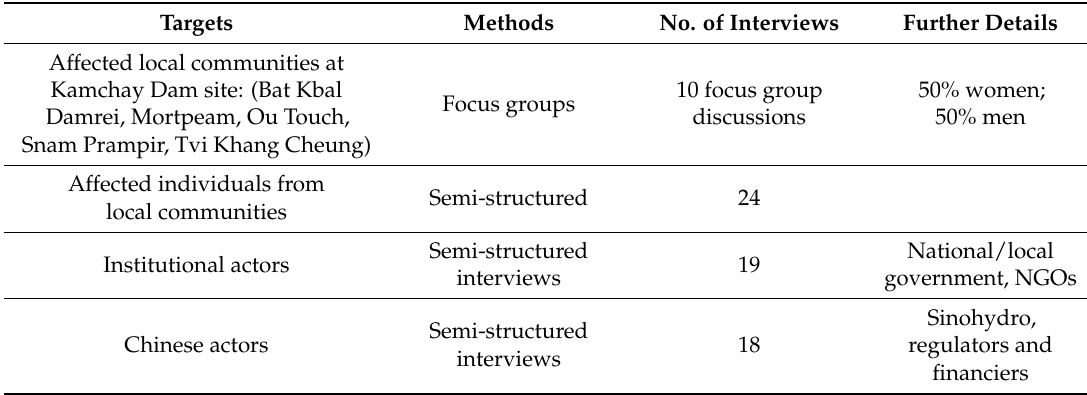
Table 3. Interview